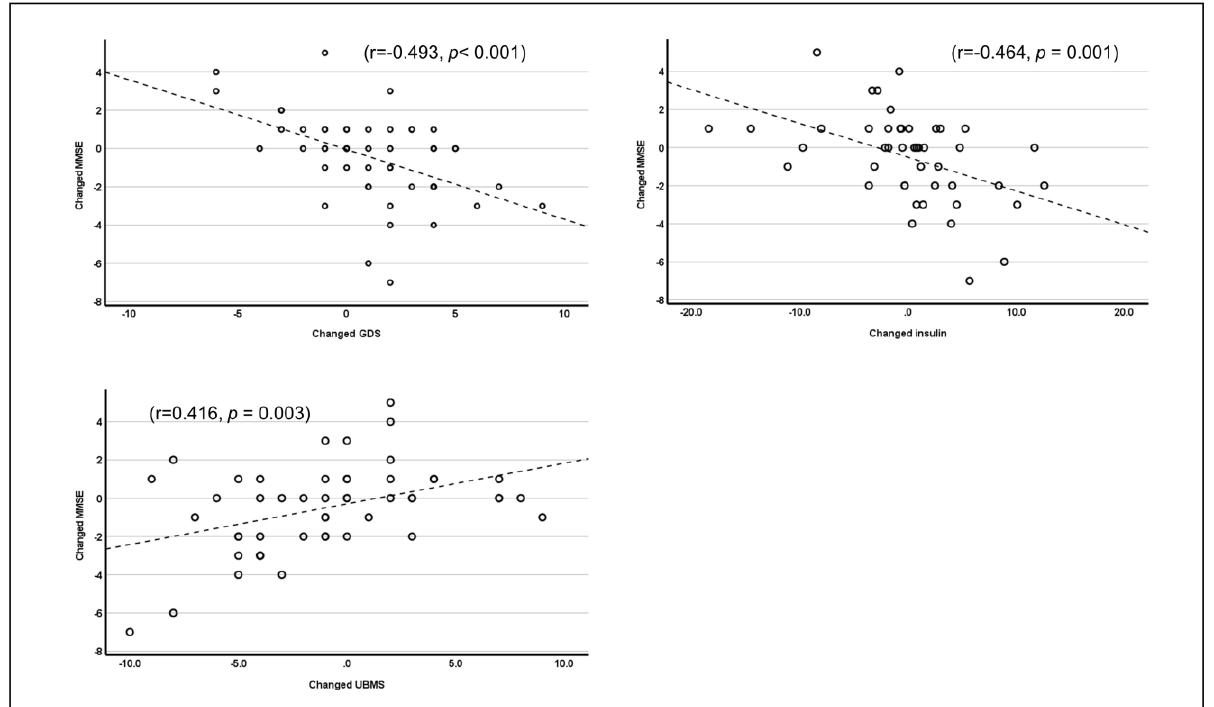
Figure 5. The relationships between changes in cognitive function, depressive symptoms, insulin, and upper body muscle strength (UBMS) in the total group.